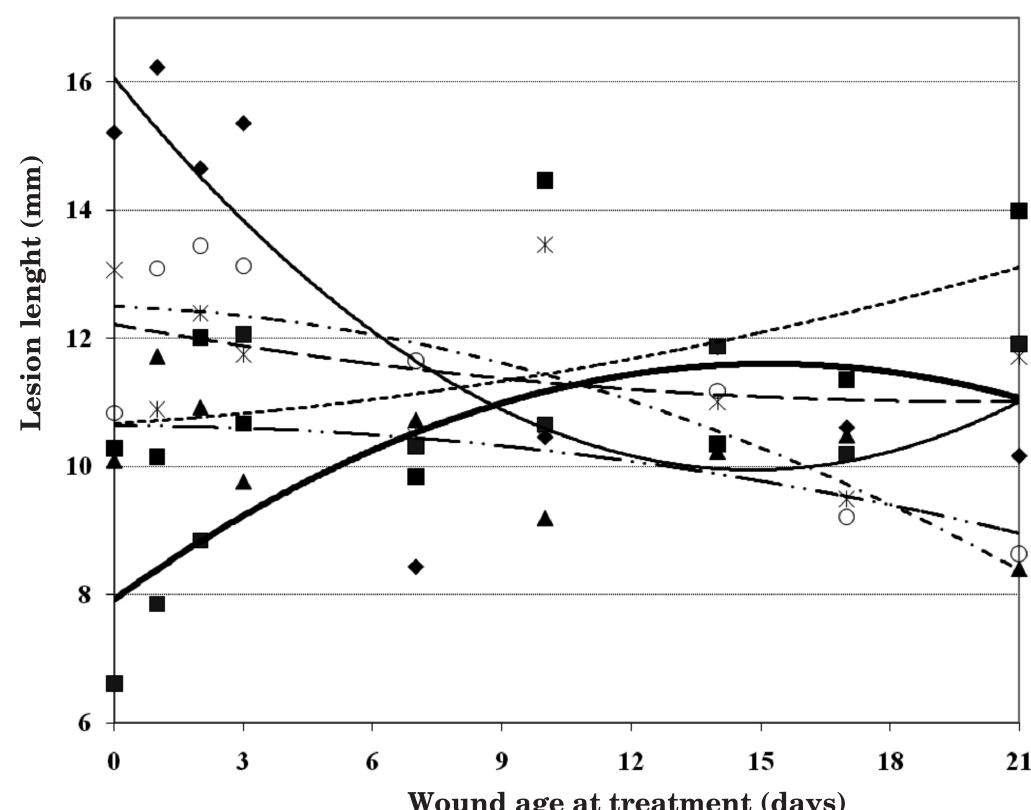
Figure 3. Quadratic regression lines ( E. lata [ – - - ], Phomopsis spp. [ - - - - ], Pa. chlamydospora [ — ], Botryosphaeriaceae spp. [ – – – ] , water [ – - – ], paint [ — ]) fitted to the mean lesion lengths ( E. lata [ ▲ ], Phomopsis spp. [ n ], Pa. chlamydo- spora [ t ], Botryosphaeriaceae spp. [ á ], water [ ¡ ], paint [ n ]) over wound age at treatment data for the significant wound age at treatment × treatment